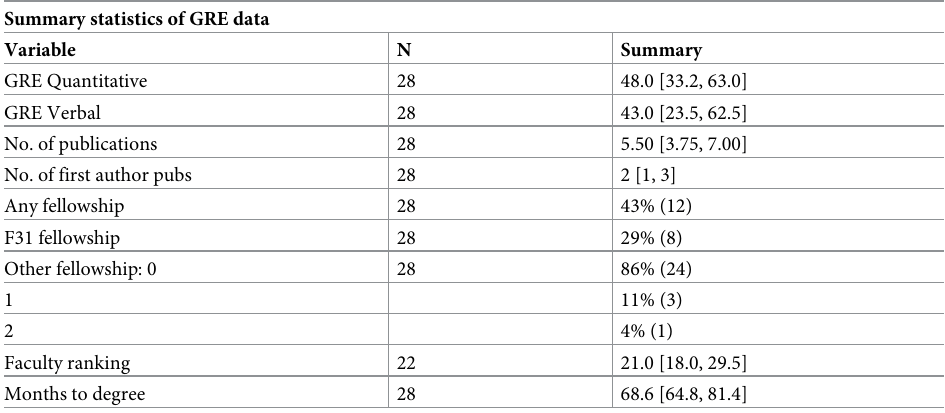
Table 2. Summary statistics of GRE